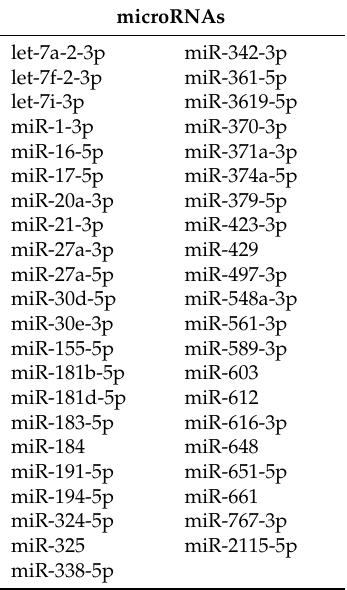
Table 2. miRNAs targeting O 6 -methylguanine–DNA methyltransferase (MGMT) derived from an in silico analysis.